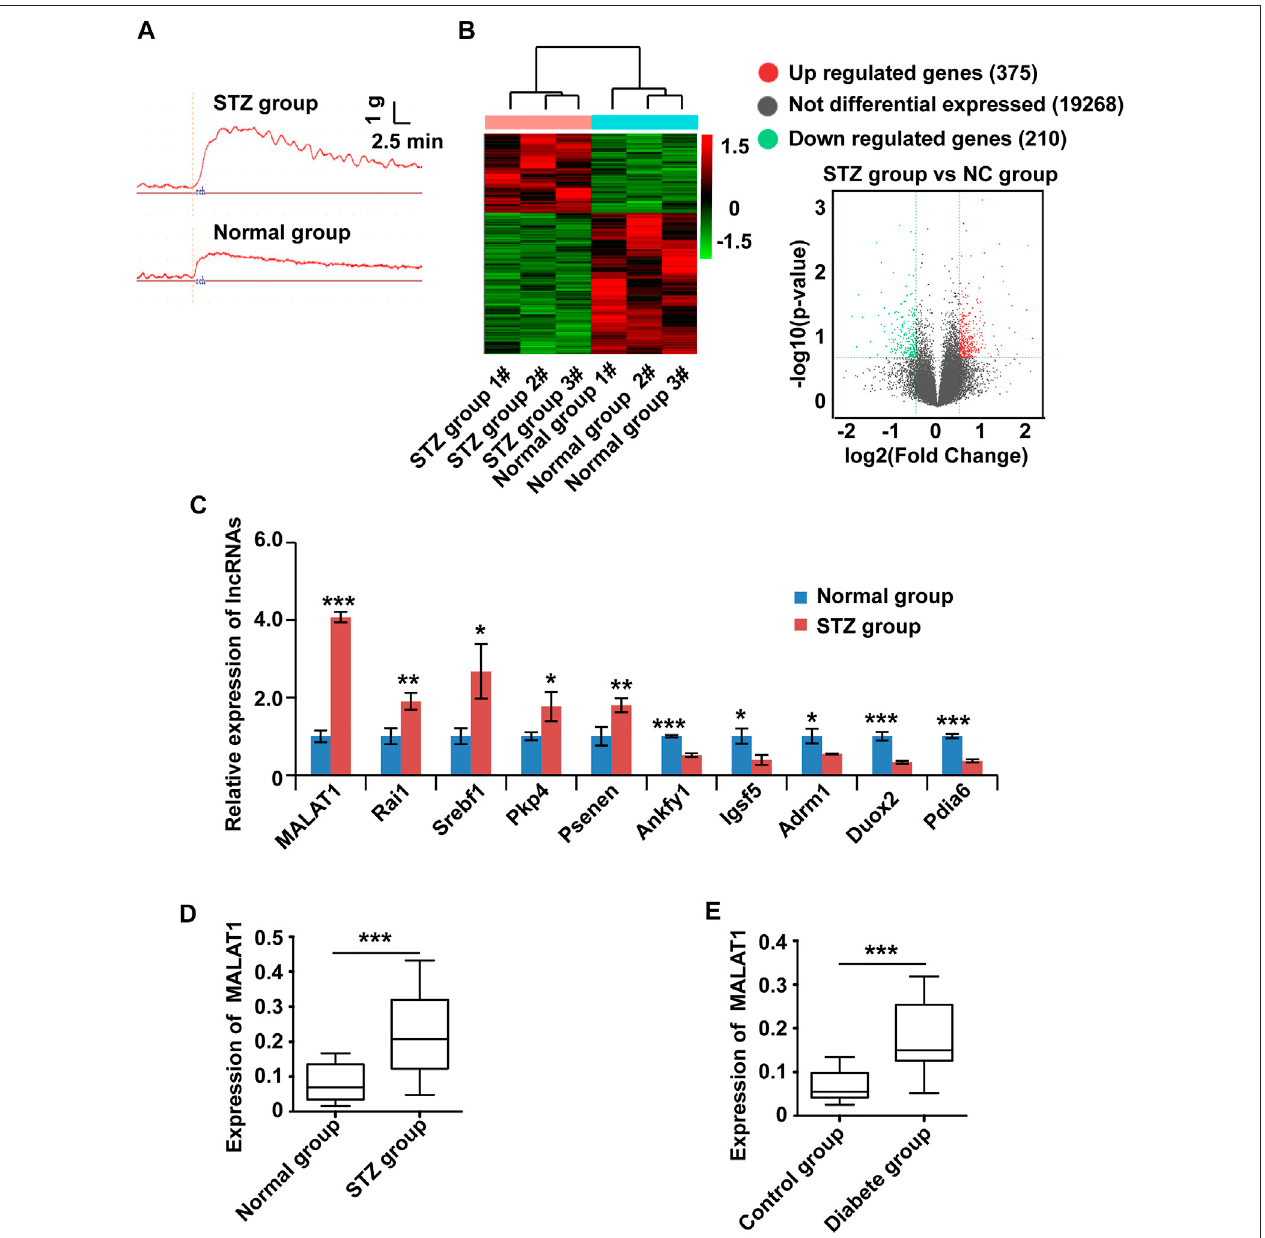
FIGURE 1 | The expression of MALAT1 is upregulated in clinical samples and a murine model of DGP. (A) Contractility of circular gastric muscle strips from streptozotocin-induced diabetic and respective control mice after administration of 100 μ mol/L CCh. (B) The hierarchical clustering and volcano analysis of differentially expressed lncRNAs. Here, 585 differentially expressed lncRNAs (210 downregulated and 375 upregulated) from hierarchical clustering were identi fi ed between DGP mice and the respective control group. The expression level of lncRNA is represented in red if it is above the average value of the gene in all samples. Conversely, greenindicates thattheexpression level oflncRNA isbelowtheaveragevalue. (C) qPCRwasusedtovalidatesigni fi cantlydifferentially expressed lncRNAs,and lncRNA MALAT1 wassigni fi cantly up-regulated in DGPmice. (D) qPCR analysisofthe expression ofMALAT1 ingastric tissues from aDGP mouse model (and control mice; n (cid:1) 10 per group). (E) qPCR analysis of the expression of MALAT1 in (adjacent) normal stomach tissues from patients who underwent gastrectomy with or without DM and DGP symptoms ( n (cid:1) 10 per group). β -Actin was used as an internal control. *** p < 0.001, ** p < 0.01, * p < 0.05.